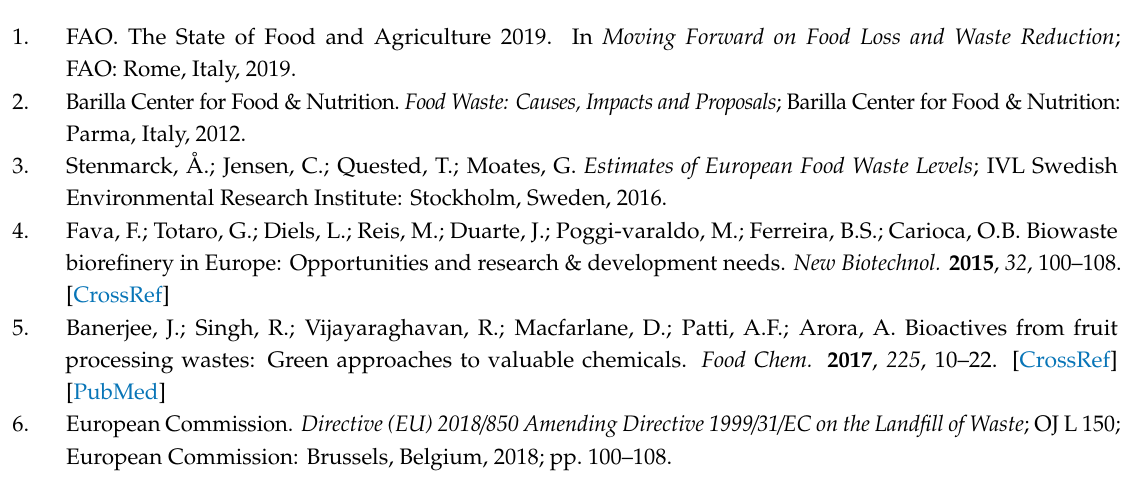
Figure S1: HPLC UV / VIS chromatograms of melon peel autohydrolysis liquors at 140 ◦